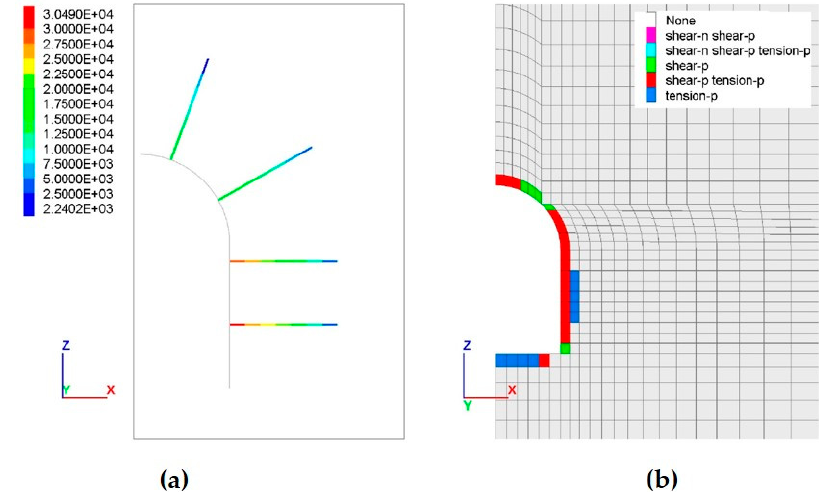
Figure 5. Transversal tunnels in sandstone formation : ( a ) rock bolts axial force [N]; ( b ) state of plasticity. Figure 6a indicates the rock bolt axial force for transversal tunnels in shale formation.